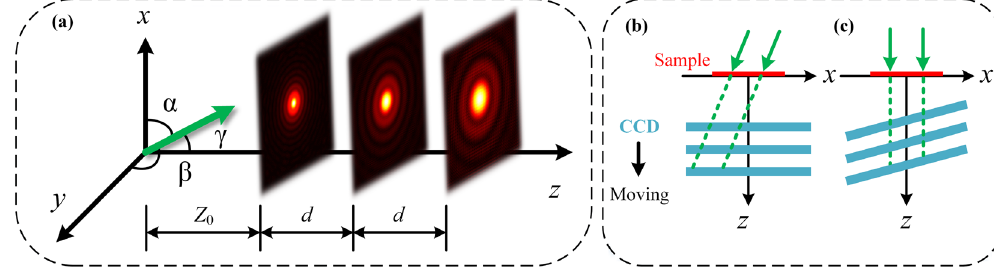
Figure 1. The model of tilt diffraction: ( a ) The schematic of free-space diffractive imaging model with tilt illumination. ( b ) and ( c ) denote oblique modality in the case of tilt illumination or